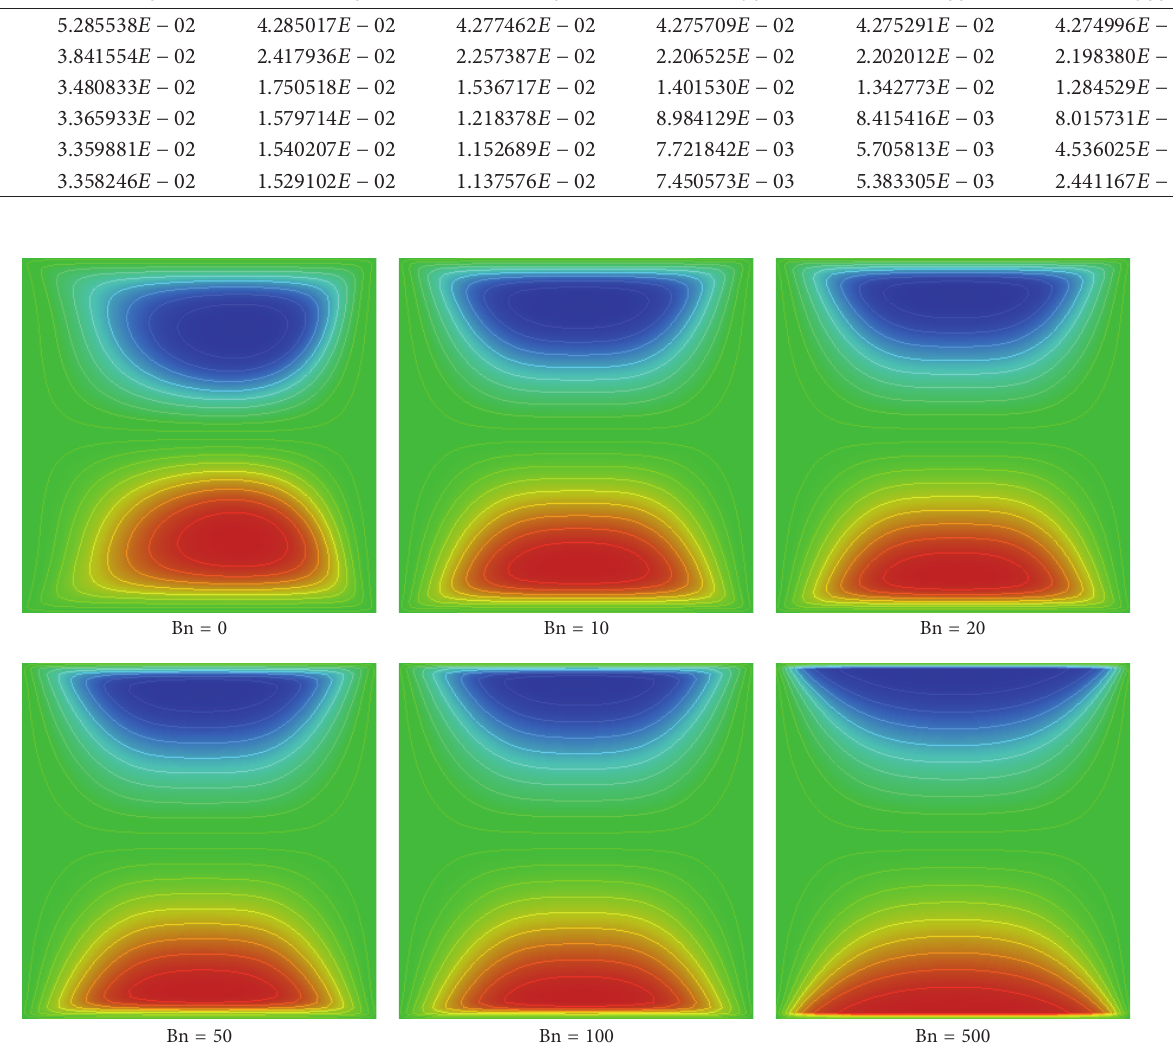
Figure 6: Stream function contours for double lid driven cavity at different values of Bingham number